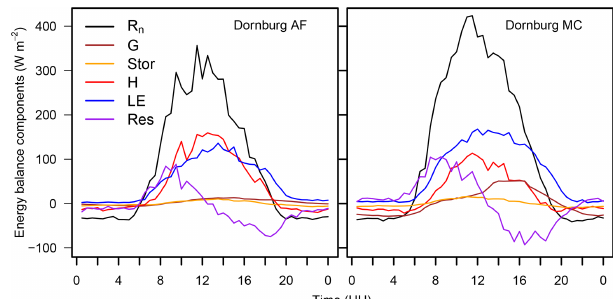
Figure 7. Median diurnal cycle of the energy balance components for Dornburg AF and MC for the campaign times (see Table B1).